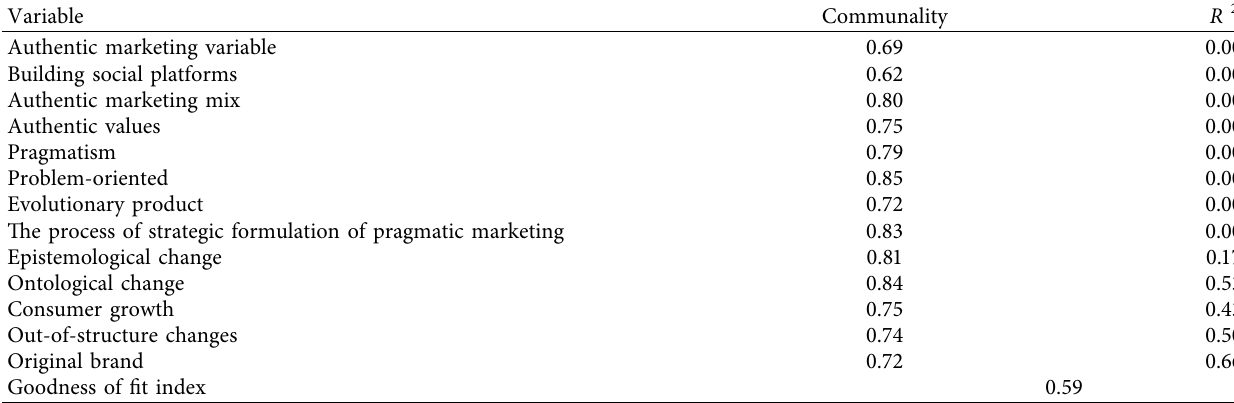
Table 6: Calculation of the fit of the internal model of second-order hypotheses.